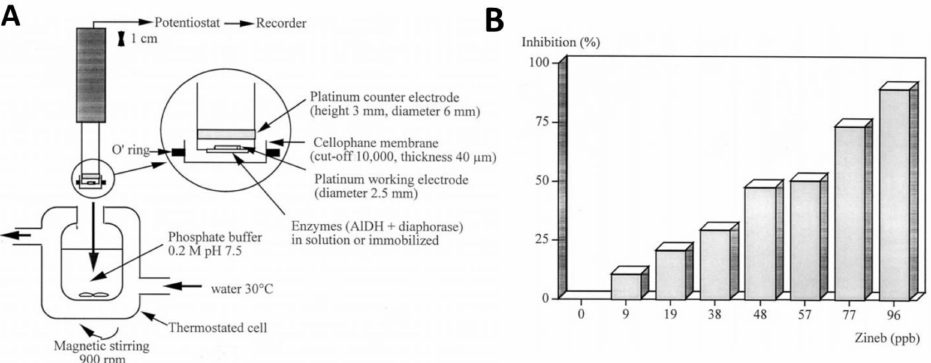
Figure 7. ( A ). Experimental setup used for the bi-enzymatic sensor for maneb and zineb. ( B ). Response of the biosensor at different concentration of zineb, expressed as percentage of the signal in the absence of the inhibitor. Reproduced from [90], by